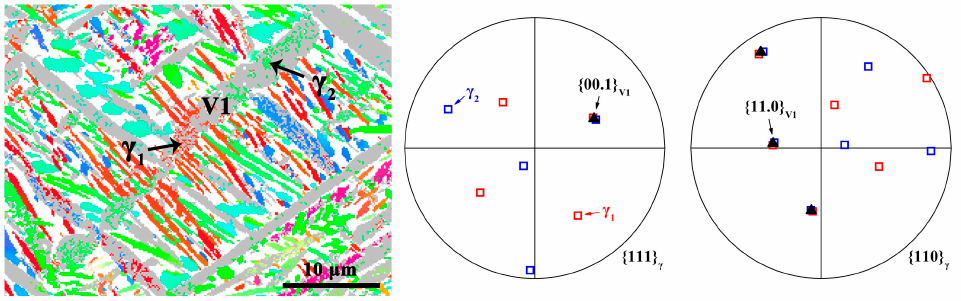
Figure 9. Microstructure of the alloy after tempering at 800 °C for 2 h. The gray color denotes the α 2 ′ phase. The pole figures of the transformed γ phase are also presented to demonstrate the Blackburn OR with the corresponding α 2 ′ laths.